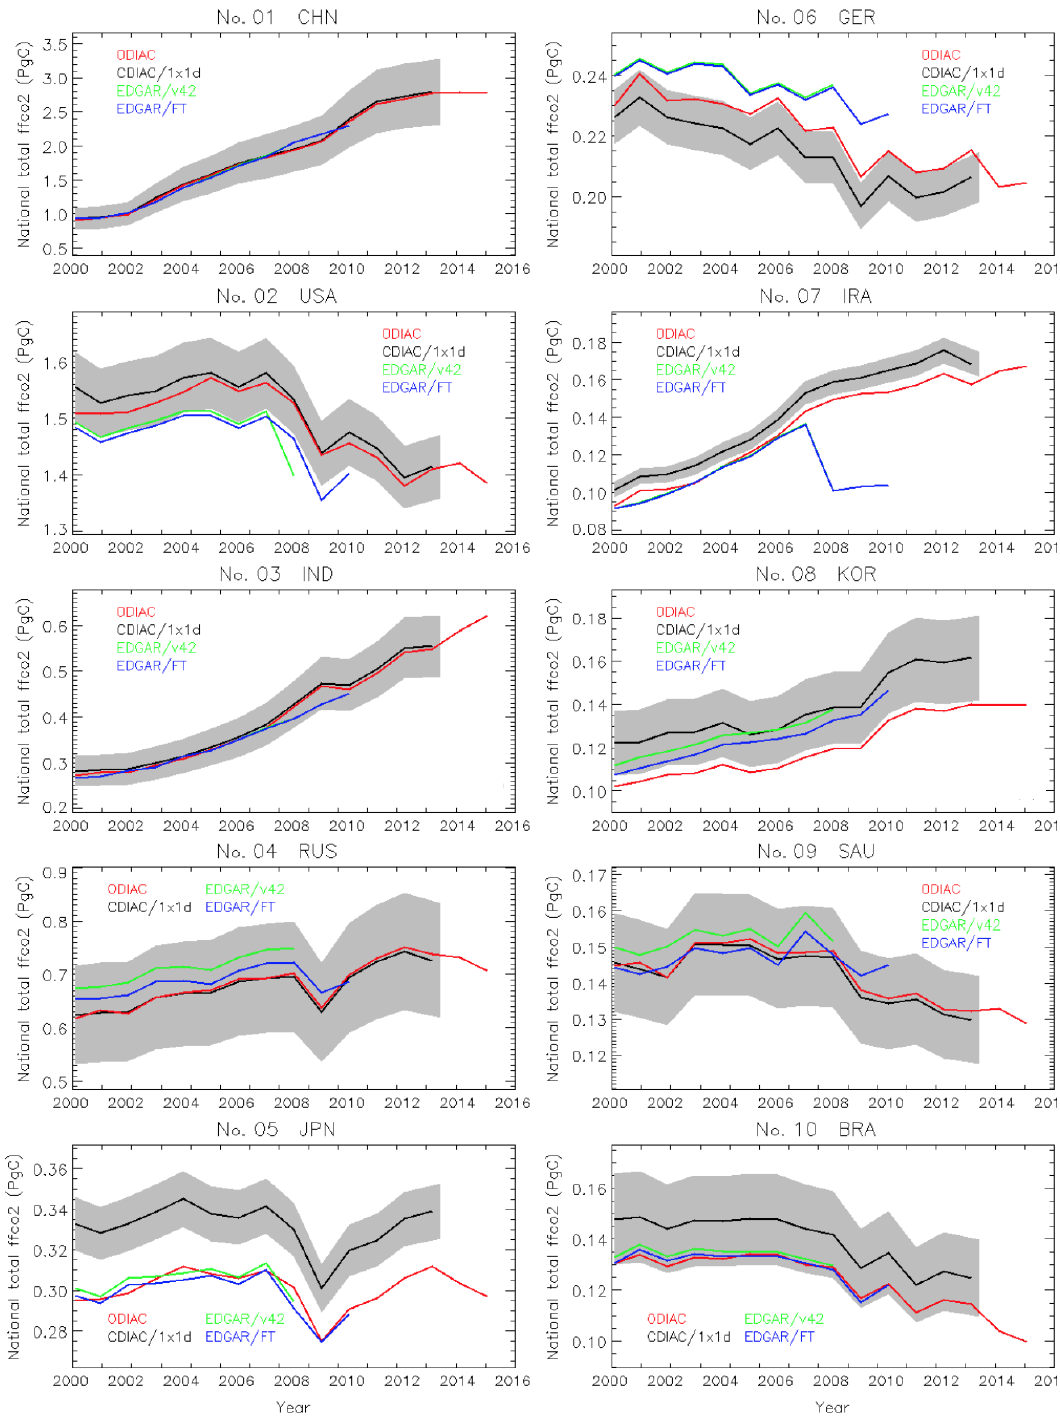
Figure 3. National emissions time series for top 10 emitting countries (China, US, India, Russian Federation, Japan, Germany, Islamic Republic of Iran, Republic of Korea (South Korea), Saudi Arabia, and Brazil). The values are given in the unit of petagrams (equal to a gigaton) of carbon per year. The values are calculated using gridded emissions data, not tabular emissions data. The national total values in the plots might thus be different from values indicated in the tabular form due to the emissions disaggregation. The shaded area in grey indicates the 2 σ uncertainty range estimated by Andres et al. (2014) (see Table